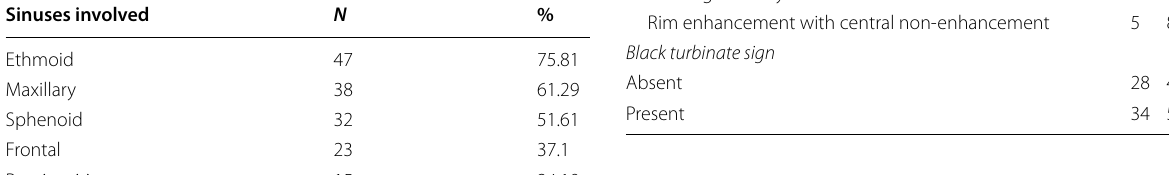
Table 3 Sino‑nasal involvement in mucormycosis